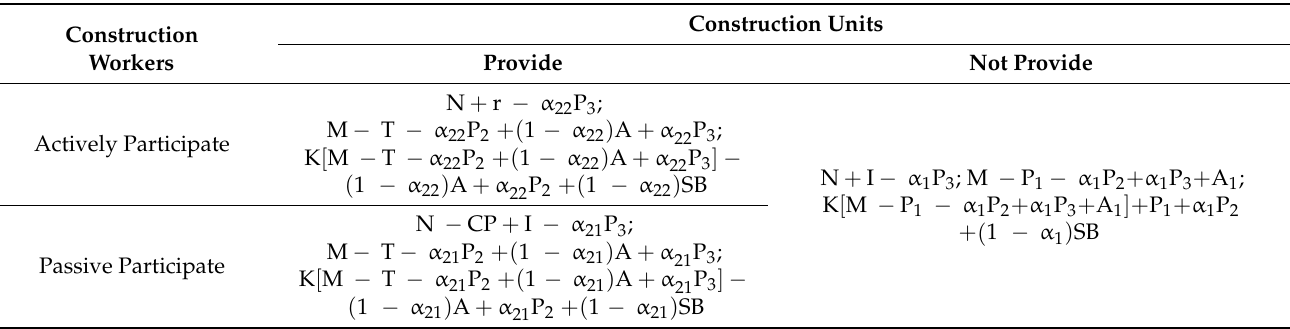
Table 2. Payoff matrix for Government–Construction Unit–Construction Workers (government